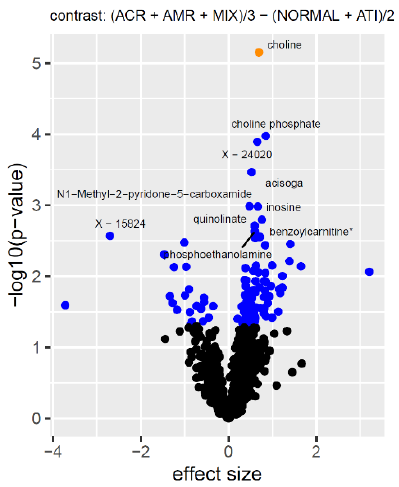
Figure 5. Volcano plot for the difference between estimated means of (ACR + AMR + mixed) and (normal + ATI). Significance levels of the metabolite associations are indicated by colors as described in Figure 3. The ten strongest associations are labeled. Full association data is available as Table S6.